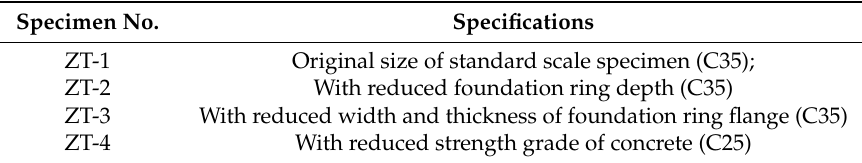
Table 1. Concrete parameters of bucket foundation.